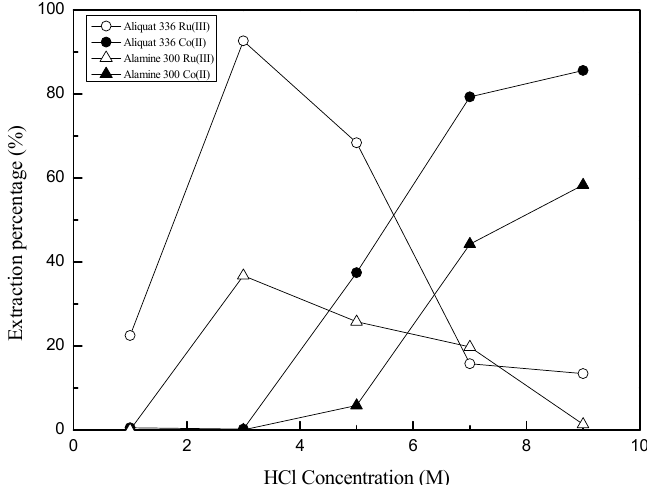
Figure 1. Effect of HCl concentration on the extraction of Co(II) and Ru(III) by Alamine 300 and Aliquat 336. ([Extractant] = 0.1 M, [Co(II)] = 100 mg/L and [Ru(III)] = 10 mg/L).